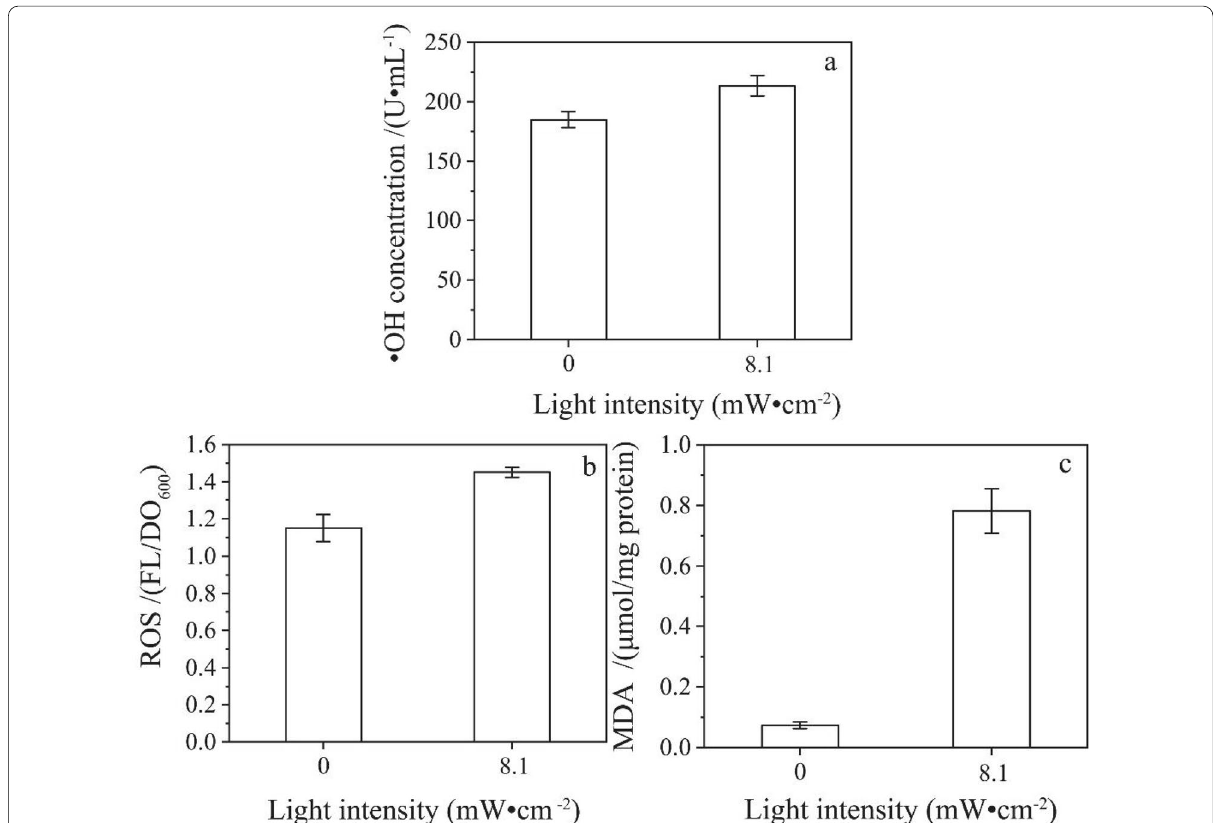
Fig. 10 The effects of light intensity on concentration)